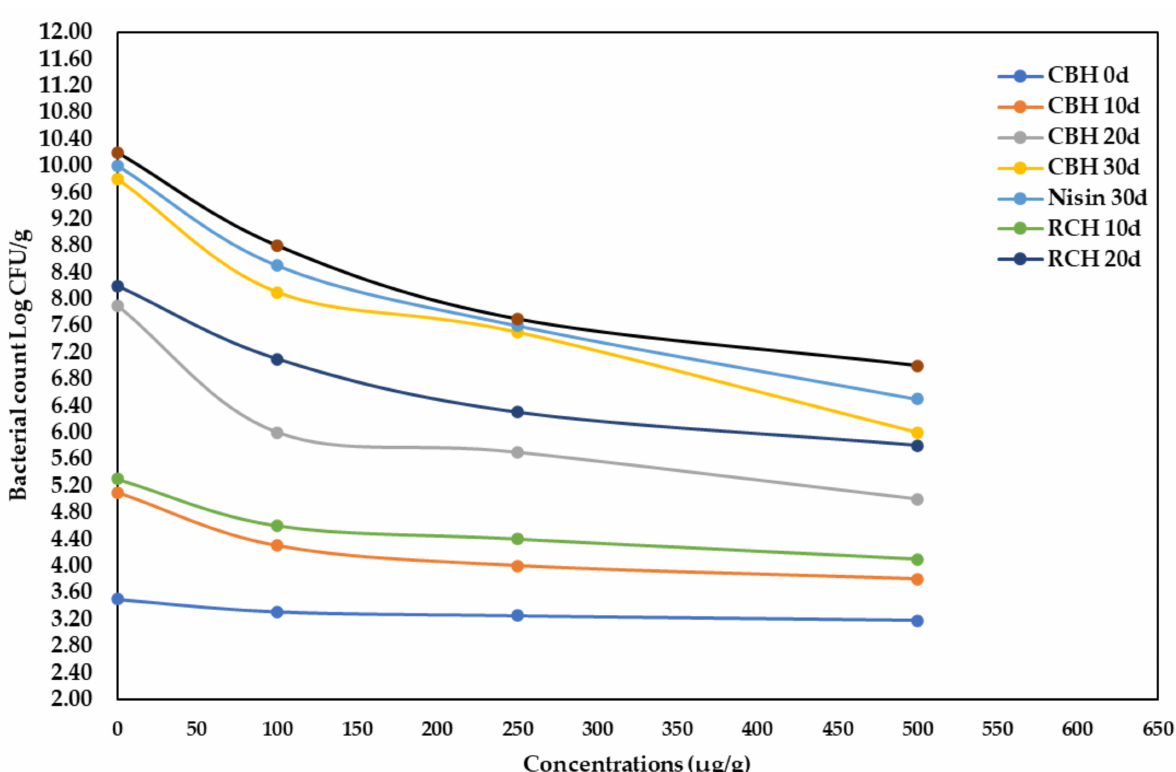
Figure 5. The alteration of total bacterial count Log CFU/g of stored buffalo steaks at 4 ◦ C during 0- and 30-days storage period, as supplemented with CBH, RCH (100, 250, and 500 µ g/g), and Nisin at 500 µ